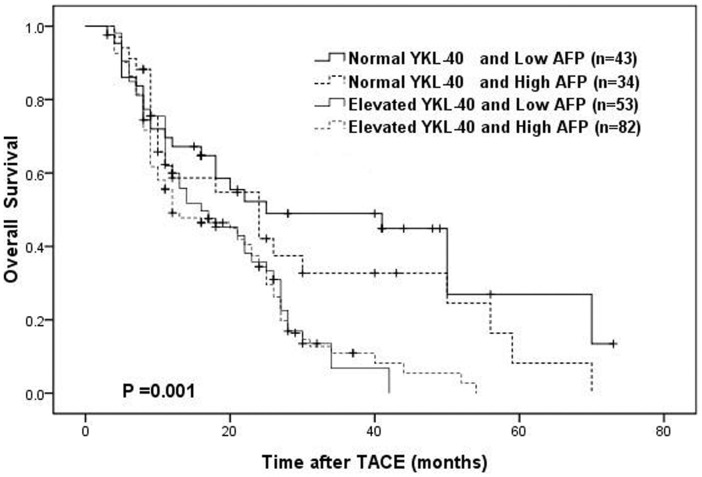
OS curves of the combination of serum YKL-40 and AFP level.